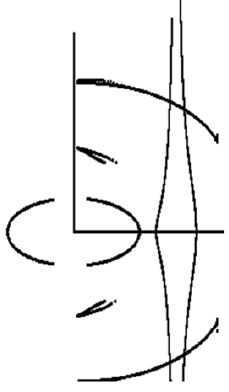
Figure 12. q = 1, KG = 120, and DK = 100.